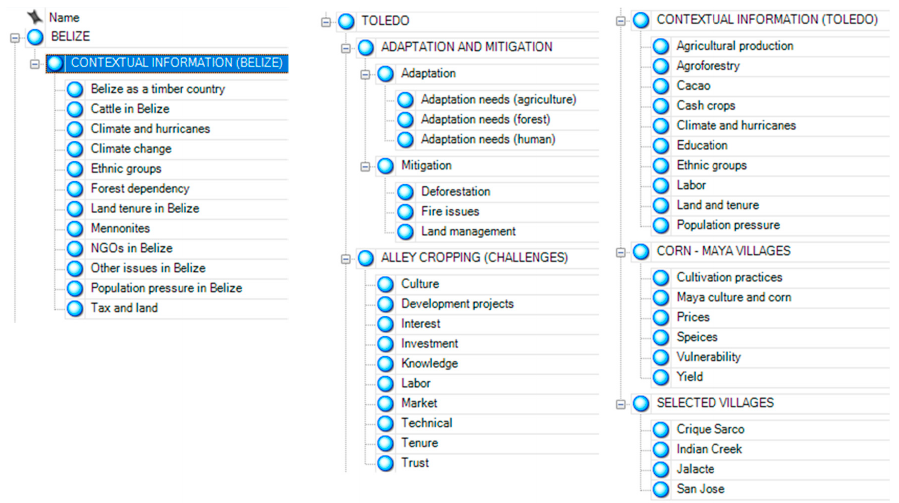
Figure 2. Overview of nodes used in NVivo to code interviews from agricultural survey in Belize.